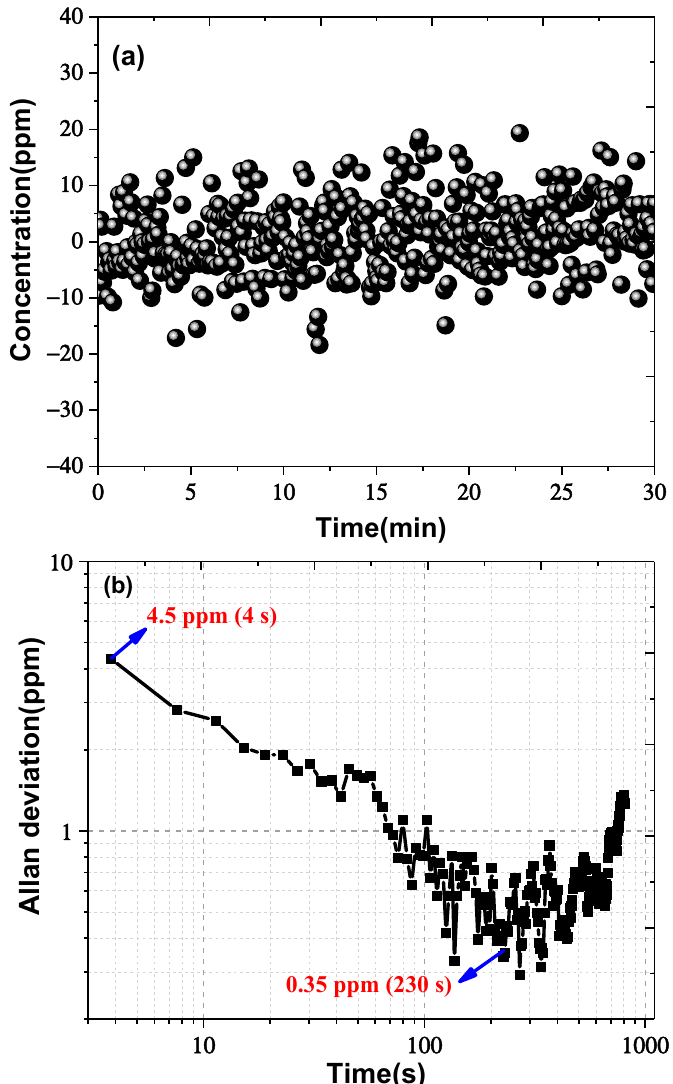
Figure 9. Stability performance of the WM-RE-OA-ICOS system: ( a ) CO 2 concentration measure- ments of the sample with zero concentration for a time of 30 min; ( b ) Allan deviation as a function of averaging time, based on the data. Each black dot represents a group of data. The average number of each group of data is 50, the average time is 4 s, and the test time is 30 min. When the average time is 4 s, the detection limit of the system is 4.5 ppm, and the average time is 230 s. The lowest detection limit of the system is 0.35